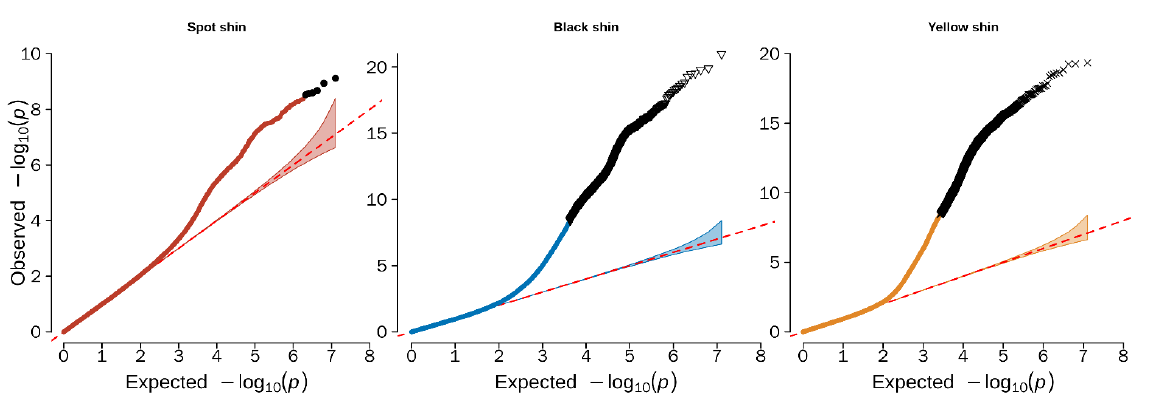
is evident only in the tail area for each color shin, indicating that population stratification was